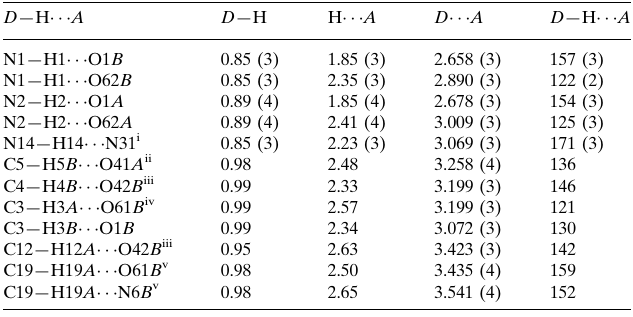
Table 1 Hydrogen-bond geometry (A˚ , (cid:4) ).